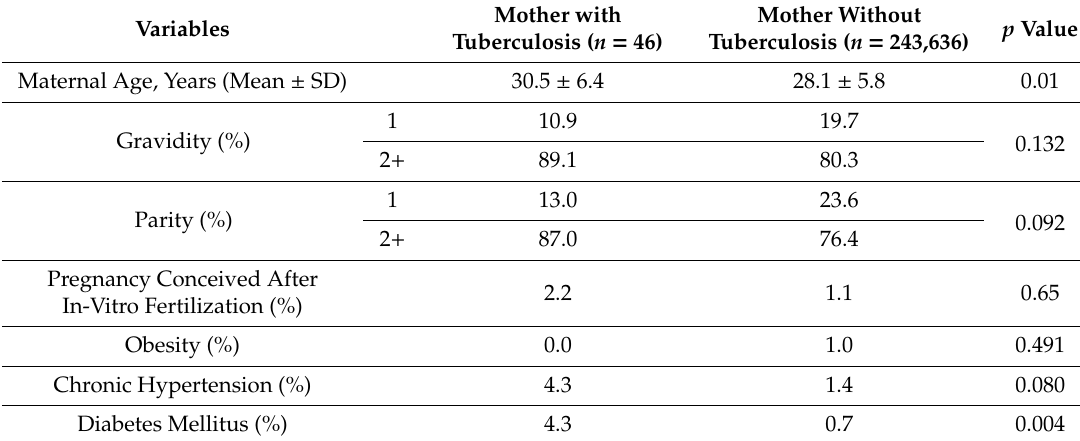
Table 1. Demographic characteristics of the study